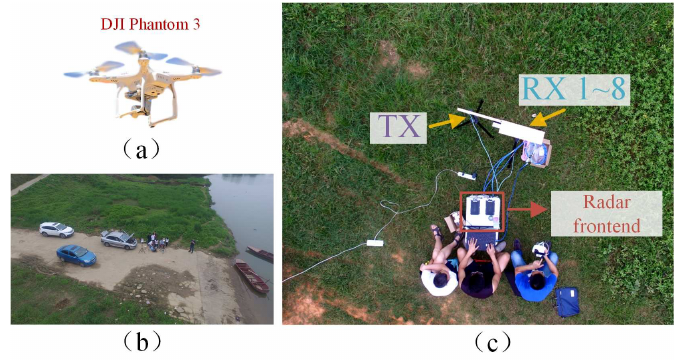
Figure 7. Measurement scenario: ( a ) unmanned aerial vehicle (UAV) as target, ( b ) experimental environment, and ( c ) top view taken by UAV.